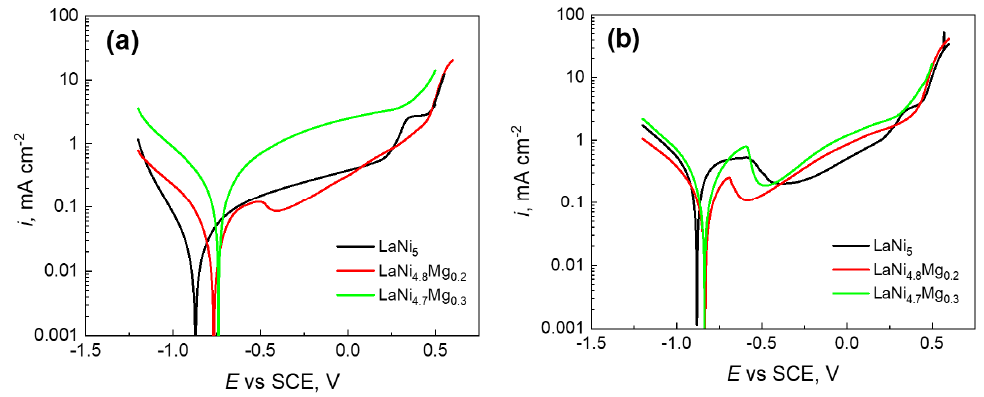
Figure 5. Polarization curves for the three studied alloys. Measurements were performed after 1-hour ( a ) and 66-hour ( b ) exposure of samples in 6M KOH